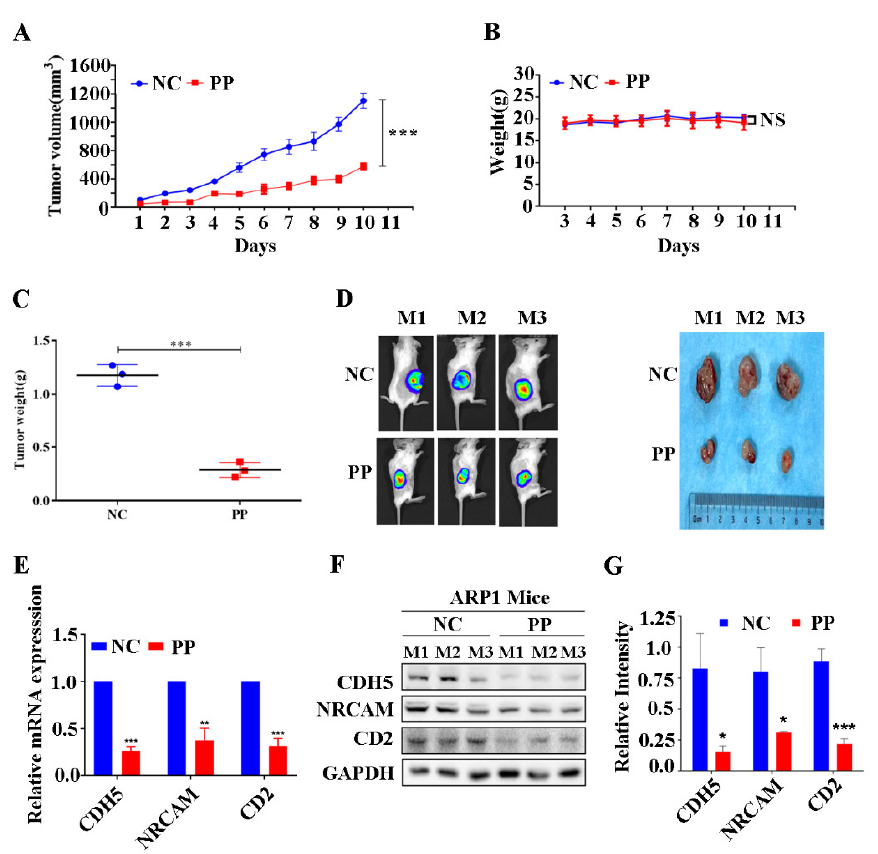
Figure 5. Periplocin attenuates tumor growth in vivo in BTZ-sensitive xenograft mouse model of MM and suppresses CAMs. ( A ) Daily changes in tumor volume of ARP1-inoculated mice after PP treatment, compared with the control untreated group. The data is presented as the mean ± SD from three mice. ( B ) Daily changes in weight of ARP1-bearing mice after PP treatment. ( C ) The changes in weight of tumor created by ARP1-bearing mice after PP treatment. ( D ) The photograph of mice bearing tumor of ARP1 cells after PP treatment before dissection (right side). The photograph of removed tumor from ARP1-cells bearing mice after PP treatment (left). ( E ) Detection in the reduced expression level of CD2, CDH5, and NRCAM genes through qRT-PCR in tissue samples of ARP1-cells bearing mice after PP treatment compared with untreated mice. ( F ) Detection of reduced expression of CD2, CDH5, and NRCAM at the proteins level through Western blot in tissue samples of ARP1-cells bearing mice after PP treatment compared with untreated mice. ( G ) Bar graph representation of the significantly reduced expression of CD2, CDH5, and NRCAM at protein levels in tissue samples of ARP1-cells bearing mice after PP treatment compared with untreated mice.. The results were considered significant statistically at p < 0.05. The more significant values were demonstrated as * p < 0.05, ** p < 0.01, *** p < 0.001, and ns: not